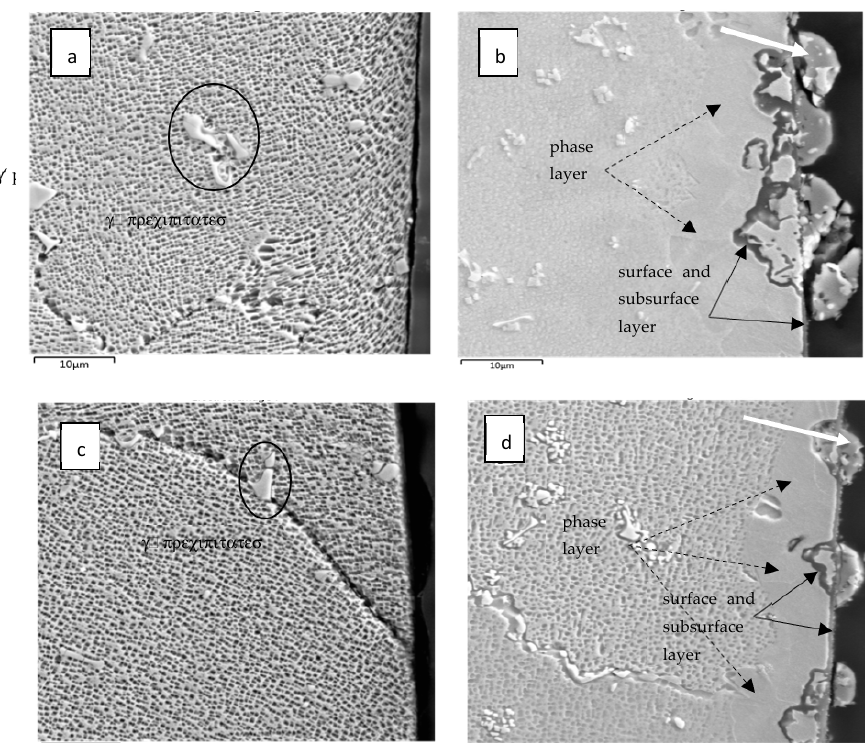
Figure 4. Microstructure of IN738 cross-sections close to the sample surface: ( a ) as-received 50R; ( b ) after He exposure; ( c ) as-received 100R; ( d ) after He exposure. γ ’ precipitates are marked with ellipses on the left. The surface is on the right; the dashed arrows mark the phase layer, and full-line arrows mark the surface and subsurface layers. In the EDX analysis, the chemical mapping of the samples after the 50R and 100R materials were exposed to He can be seen in Figures 5 and 6, respectively. The fine-grained layer at the surface (Figure 4, marked with dashed arrows) is enriched with Cr, Co, Mo and depleted of Ni, Ti and Al elements (see Figures 5 and 6). Such inner phase of similar composition does not occur in common nickel-based alloys, which do not contain Co [11,14]. The surface protrusions (Figure 4, marked with white full-line arrows) are Ti, Cr and Al-containing oxides. The thin surface layer (Figure 4, marked with black full-line arrows) is likely Al-based oxide scale. Al-oxide-rich regions are also found below the sur- face protrusions. Particles (Ti, Nb, Ta)C are visible in Figures 5 and 6, and probably Cr 23 C 6 is seen at the grain boundaries on Figure 6.